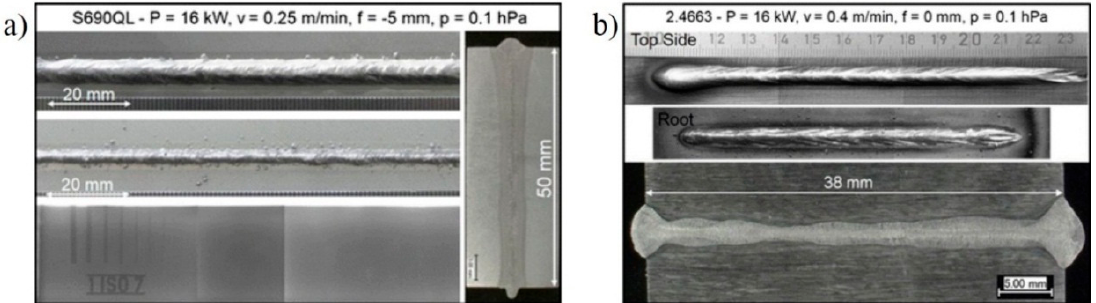
Figure 12. The survey of weldable plate thicknesses/materials with laser welding under vacuum. Reproduced with permission from [31], Springer, 2016. ( a ) Laser welding under vacuum of unalloyed steel S690QL, ( b ) Laser welding under vacuum of nickel-base alloy 617.